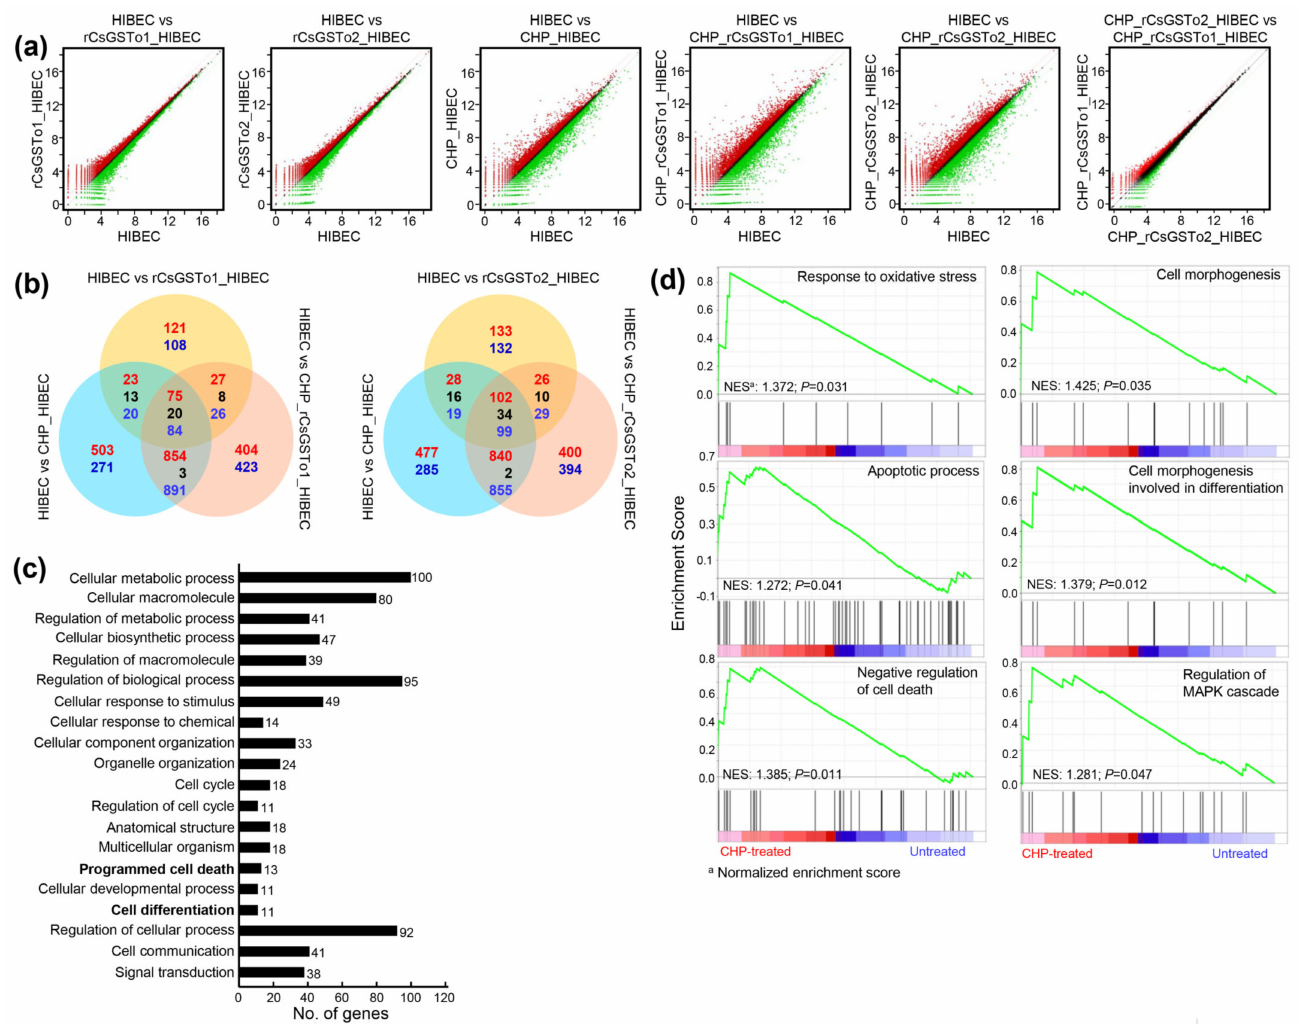
Figure 3. rCsGSTos induced transcriptomic changes in HIBECs upon oxidative stimulus. ( a ) Scatter plots of microarray defined genes showing expressional changes. Control and rCsGSTos-incorporated HIBECs were incubated in the presence or absence of CHP for 24 h and analyzed by Quant-RNAseq. The raw reads of normal control were > 22.2 M and those of cells incorporated with rCsGSTos without stress were > 24.8 M (CsGSTo1) and > 20.7 M (CsGSTo2). The raw reads of control cells and rCsGSTo-incorporated cells exposed to stress were > 13.7 M, > 18.4 M (CsGSTo1) and > 18.0 M (CsGSTo2), respectively. The plot is on a log2 transformed scale. ( b ) Venn diagram shows the number of differentially expressed genes. Overlap of each set of genes is shown. Red, blue and black letters indicate the number of up-, down- and contra-regulated genes, respectively. ( c ) Quant-RNAseq array defined distribution of genes related to cellular process in biological process at tertiary hierarchy are presented by Blast2GO. ( d ) Among 412 genes showing significant transcriptional alteration by GSEA ( p < 0.05), genes functionally engaged in response to oxidative stress, apoptotic process, negative regulation of cell death, cell morphogenesis, cell morphogenesis involved in differentiation and regulation of MAPK cascade were